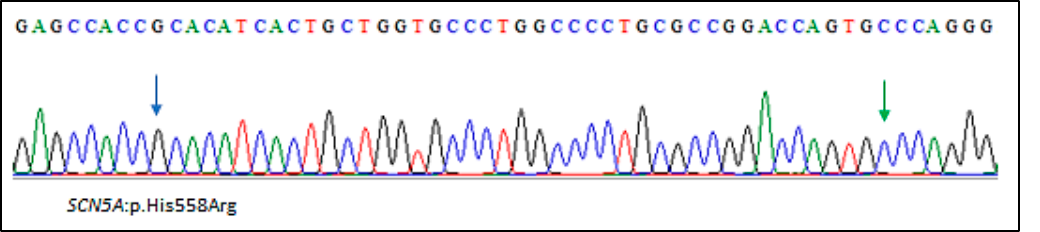
Figure 4. Parasternal long axis view ruling out any mitral valve prolapse ( A ). Mitral valve leaflets are thin without chordae elongation. Parasternal long axis view with color Doppler ruling out any mitral regurgitation in systole ( B ).